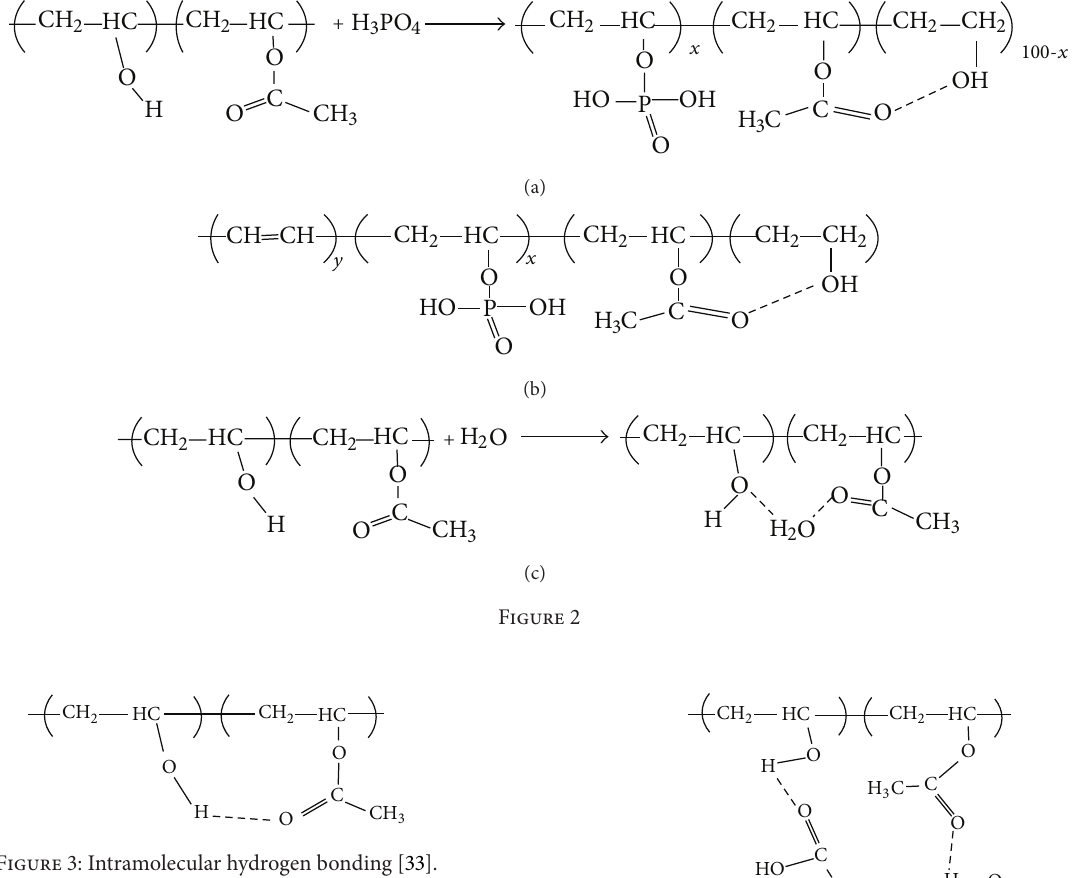
Figure 3: Intramolecular hydrogen bonding [33].